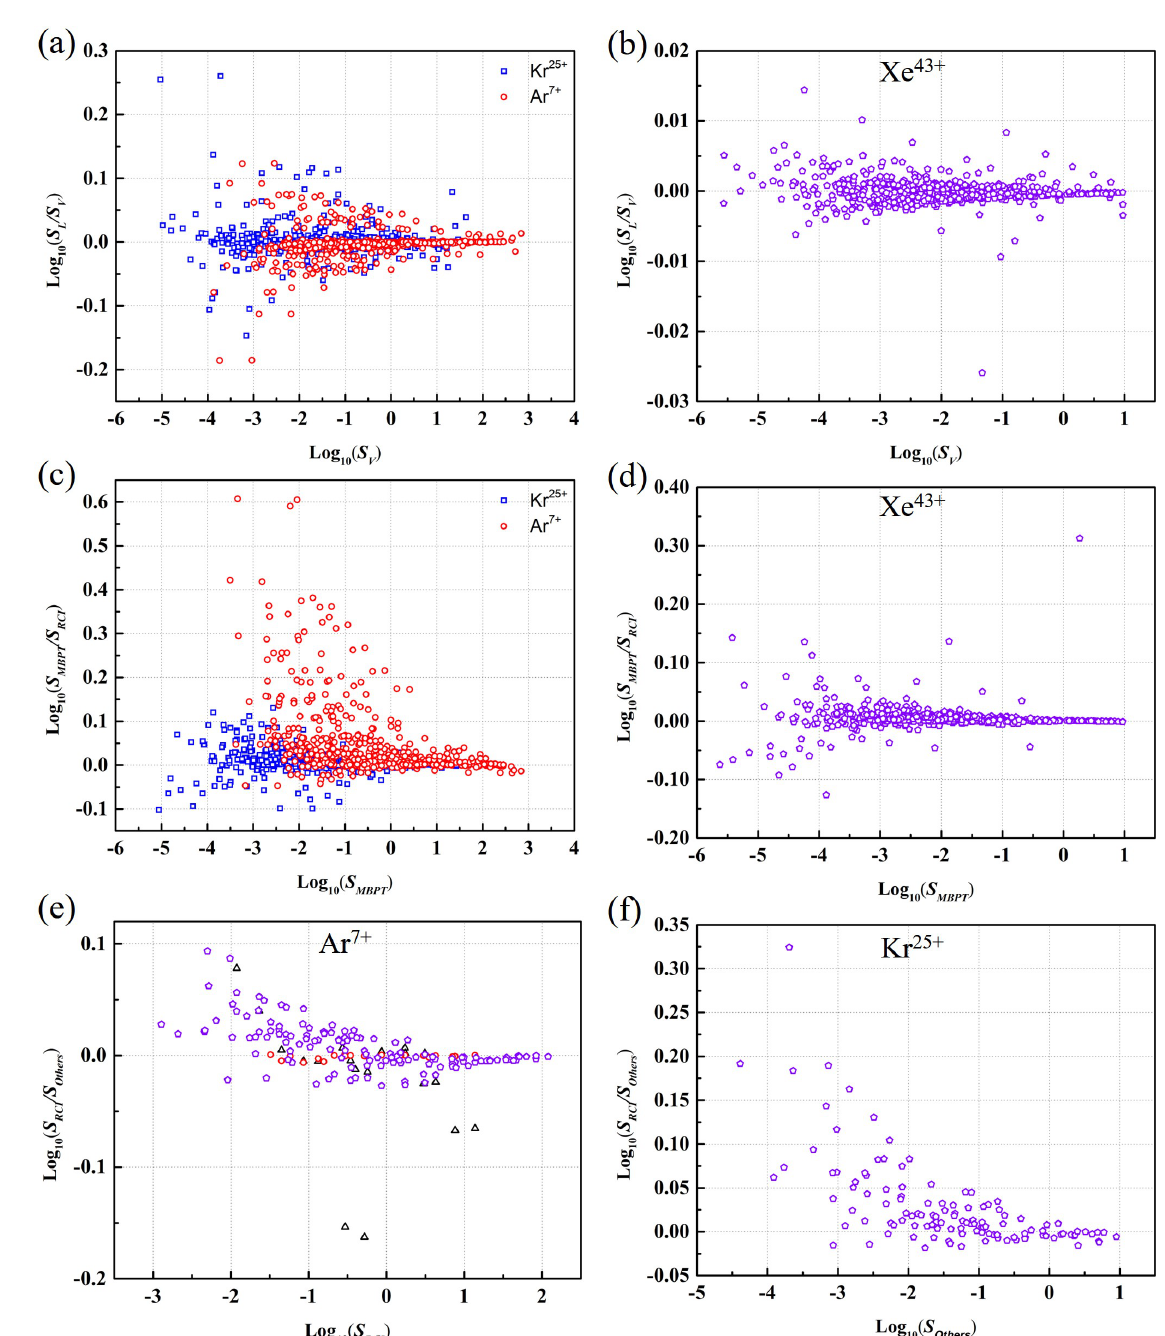
Figure 3. ( a , b ): Comparisonof the line strengths computed using the MCDHF − RCI in length ( S L ) and velocity ( S V ) gauges; ( c , d ): Comparison of the line strengths computed using the MCDHF − RCI ( S RCI ) and MBPT ( S MBPT ) methods; ( e ): The relation between the log 10 ( S RCI ) and log 10 ( S RCI / S [ 20 ] ) (circle), log 10 ( S RCI / S [ 22 ] ) (pentagon), log 10 ( S RCI / S [ 48 ] ) (triangle); ( f ): The relation between the log 10 ( S [ 22 ] ) and log 10 ( S RCI / S [ 22 ] )